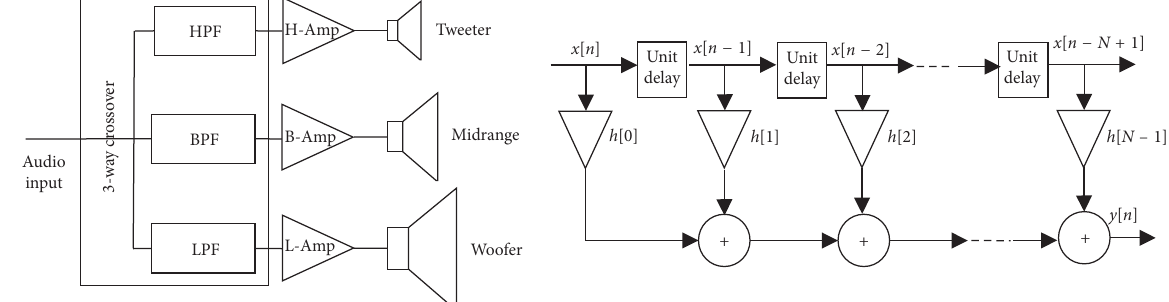
Figure 12: Active 3-way crossover and N-tap FIR filter logical